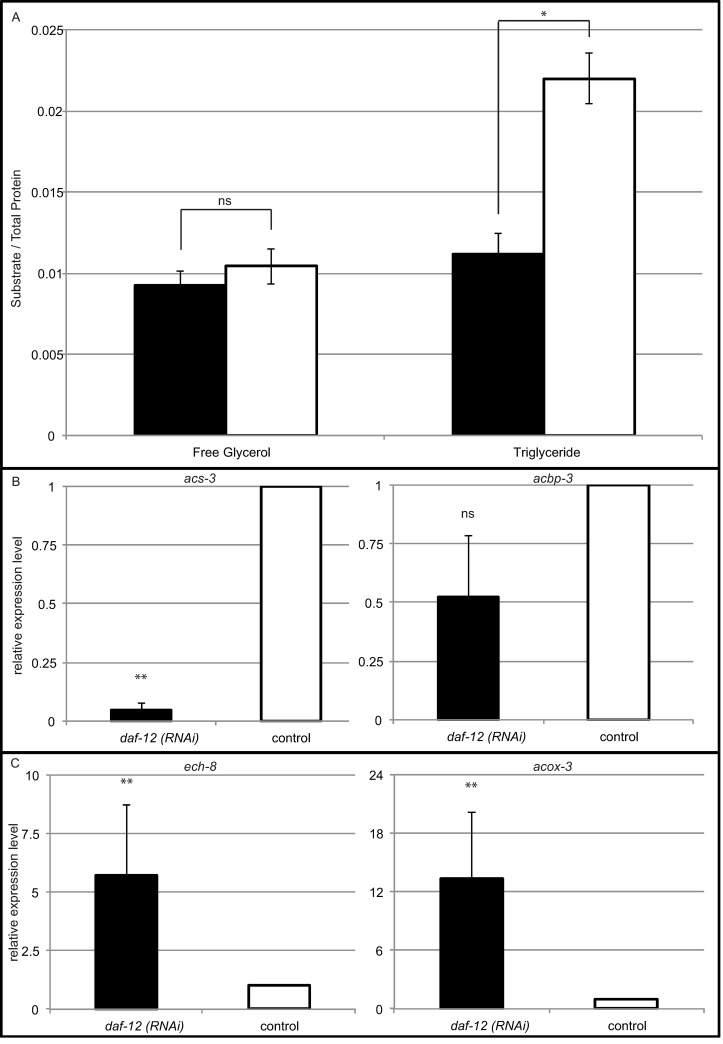
Suppression of daf-12 within Strongyloides ratti results in multiple changes in metabolism.Triglyceride content is statistically significantly reduced in daf-12(RNAi) larvae (black) than control larvae (white) following “Late-stage” soaking (A) (p-value <0.001). Similarly, the aerobic metabolism genes acs-3 (p<0.001) and acbp-3 (p = 0.057) have decreased expression in daf-12 (RNAi) larvae (B), while the anaerobic metabolism genes ech-8 (p = 0.001) and acox-3 (p<0.0001) are upregulated in daf-12 (RNAi) (C). To determine fatty acid stores, total triglyceride and free glycerol were measured from worm lysates and are plotted against total protein in the sample. This experiment was performed twice. To determine changes in gene expression, control larvae expression was normalized as 1 and fold change was calculated using the ΔΔCt method (see Materials and Methods) to determine change in expression of the genes of interest. Fold change shown is the mean fold change of the gene of interest compared to 3 control genes (tbb-1, gpd-2, rpl-37 [55]) taken from at least 3 biological replicates with each biological replicate consisting of 3 technical replicates. Error bars represent standard deviation. Mann Whitney U analysis was performed to determine statistical significance. ns indicates a not statistically significant difference (p-value >0.01), * indicates a statistically significant difference (p-value ≤0.01 - ≥0.001), ** indicates a highly statistically significant difference (p-value ≤0.001).